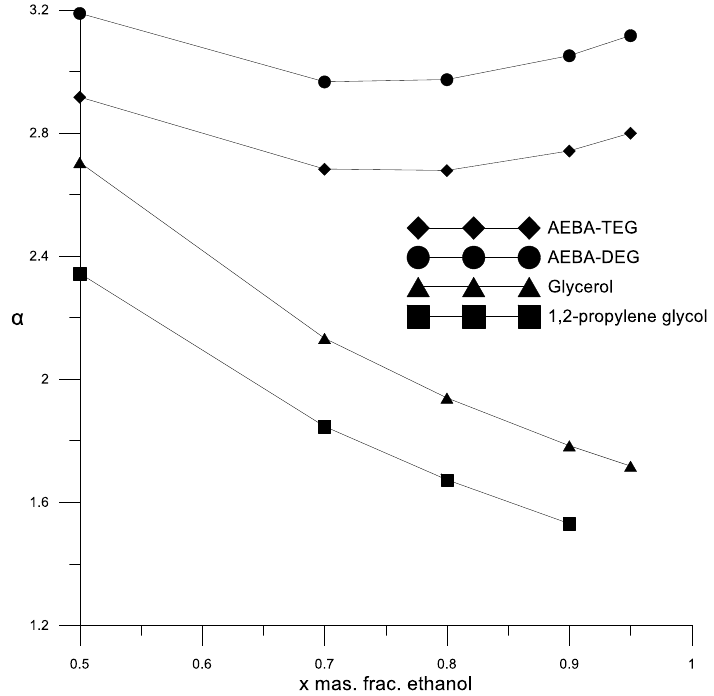
Figure 6. The coefficient of the components relative volatility of the ethanol–water mixture in the presence of various extractants.